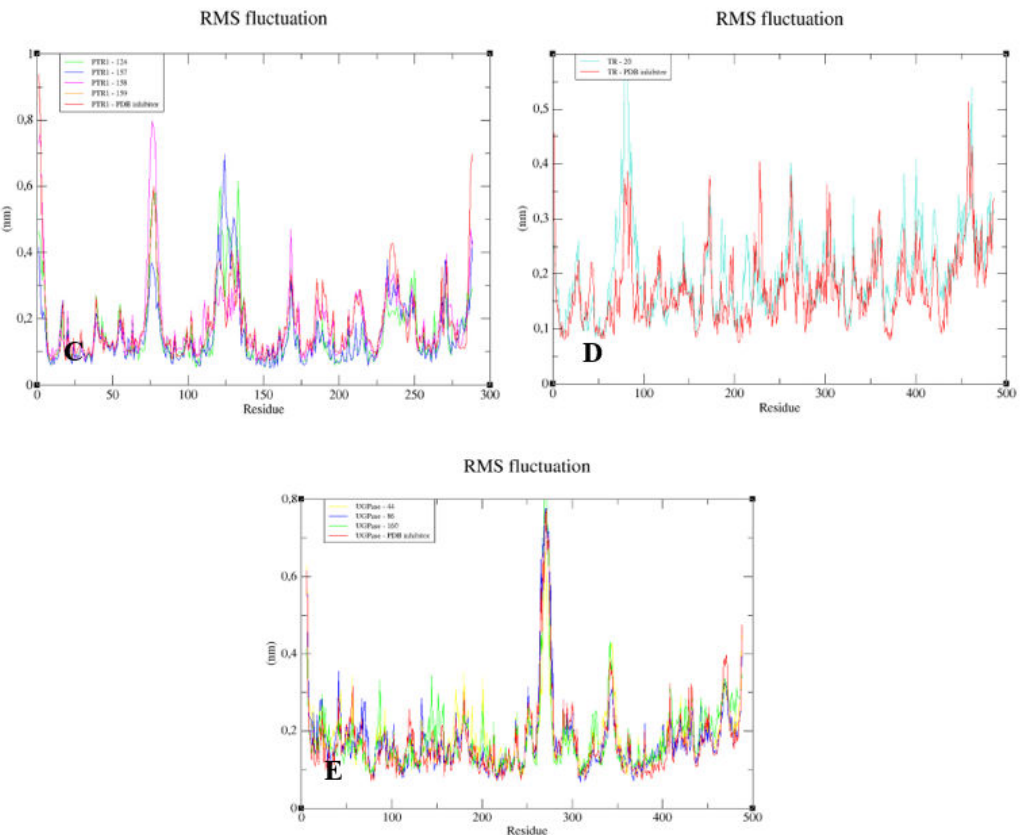
Figure 11. Root-mean-square fluctuation (RMSF) values for the C α atoms of enzymes complexed with lignans and the PDB ligand. ( A ) GPDH. ( B ) DHODH. ( C ) PTR1. ( D ) TR. ( E )